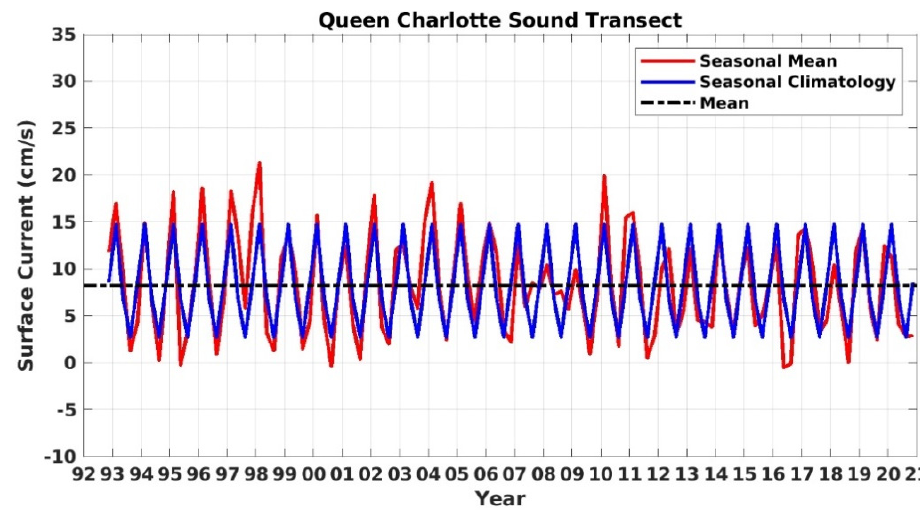
Figure 5. Same as Figure 3 but at the Queen Charlotte Sound Transect.